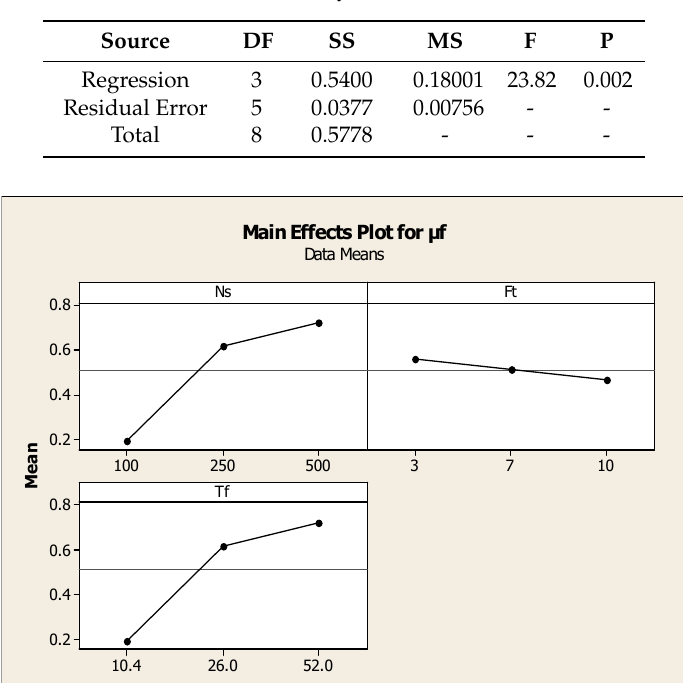
Figure 8. Effect of torque and friction time on µ f .